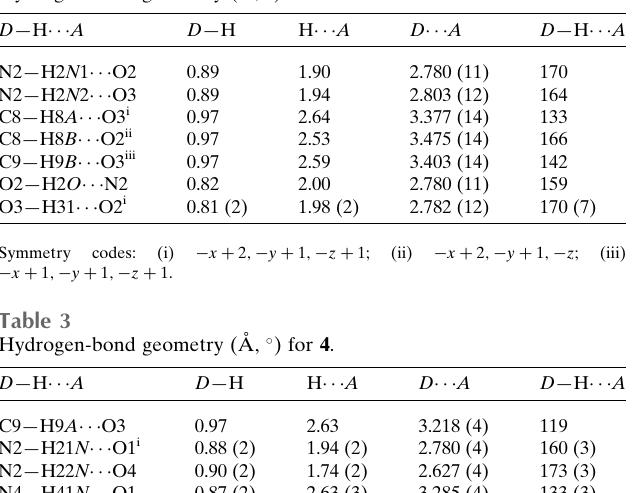
Table 2 Hydrogen-bond geometry (A˚ , (cid:5) ) for 3 .